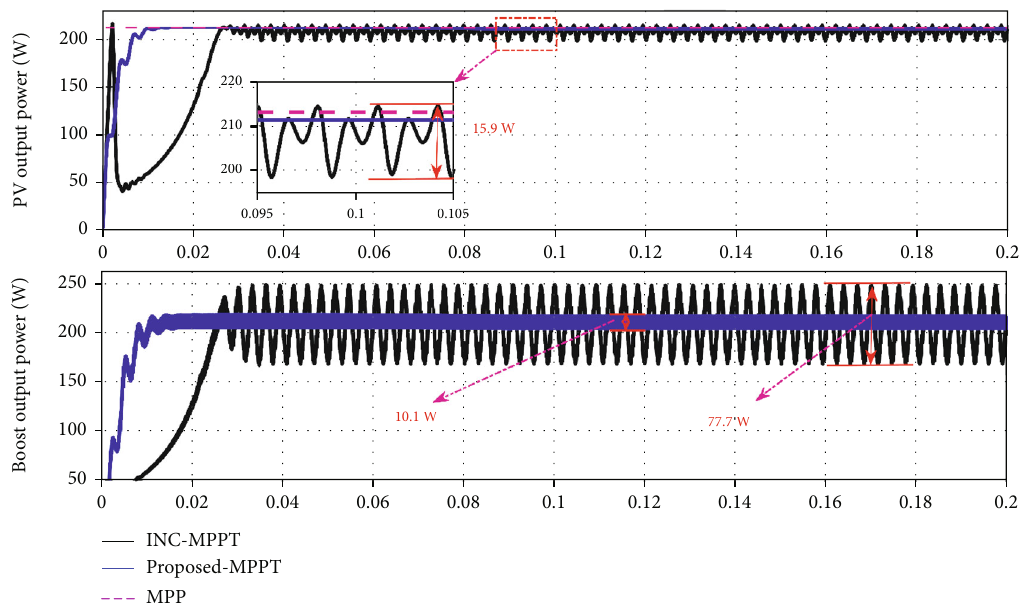
Figure 8: Simulation result curves of the output power of the photovoltaic module and the boost converter under STC.